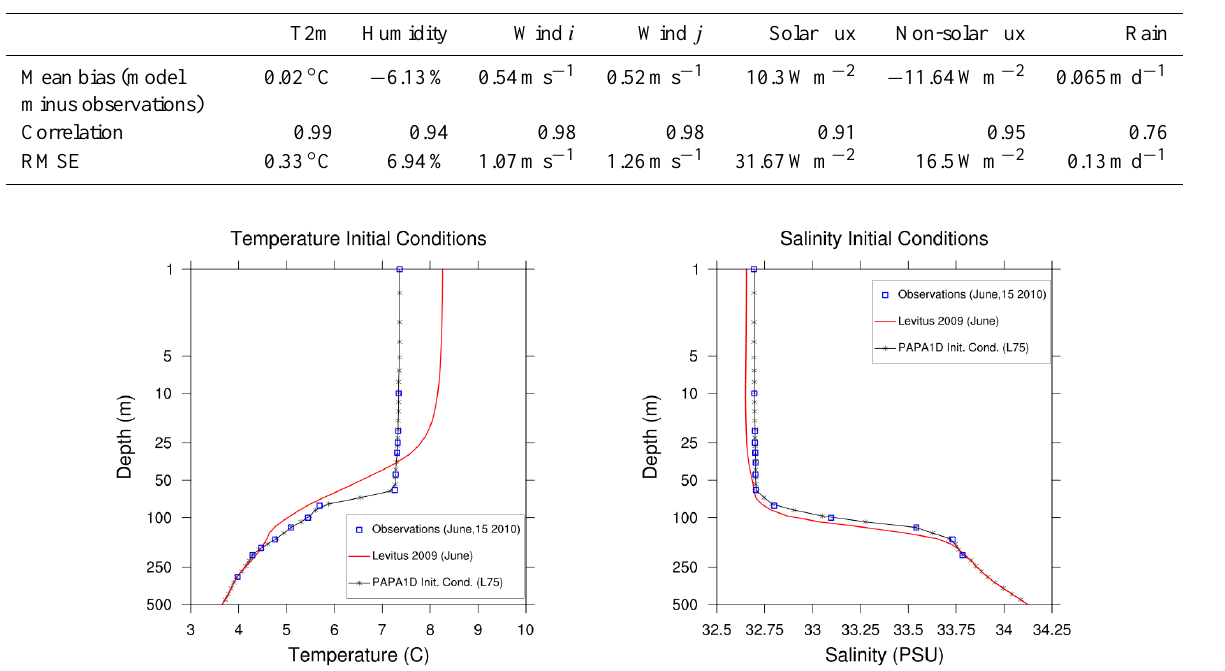
Figure 6. Initial conditions (black line and star) of temperature (left) and salinity (right) from measurements at the PAPA station (blue square) on 15 June 2010 and Levitus 2009 climatology data